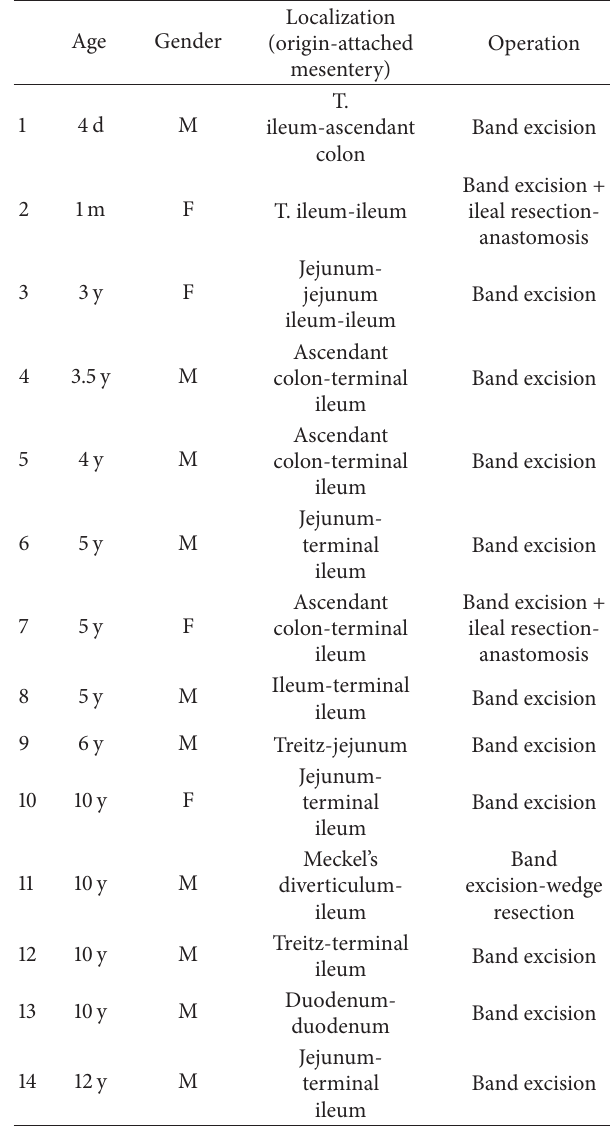
Table 1: The location of the congenital band and the surgery type.